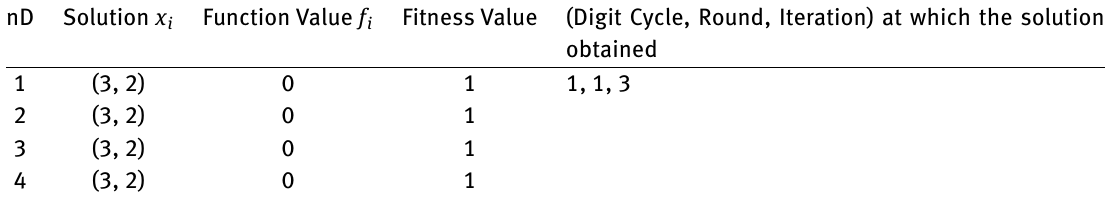
Table 20: Digit Cycle Results for Himmelblau’s function with 2 variables